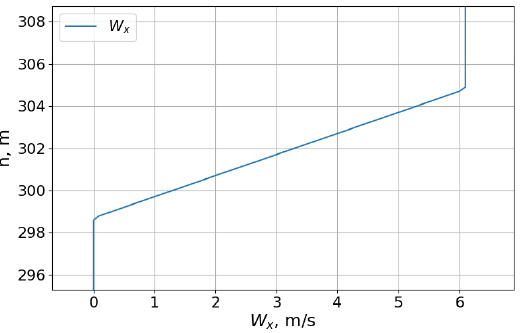
Figure 14. Wind profile for the dynamic soaring SUAV